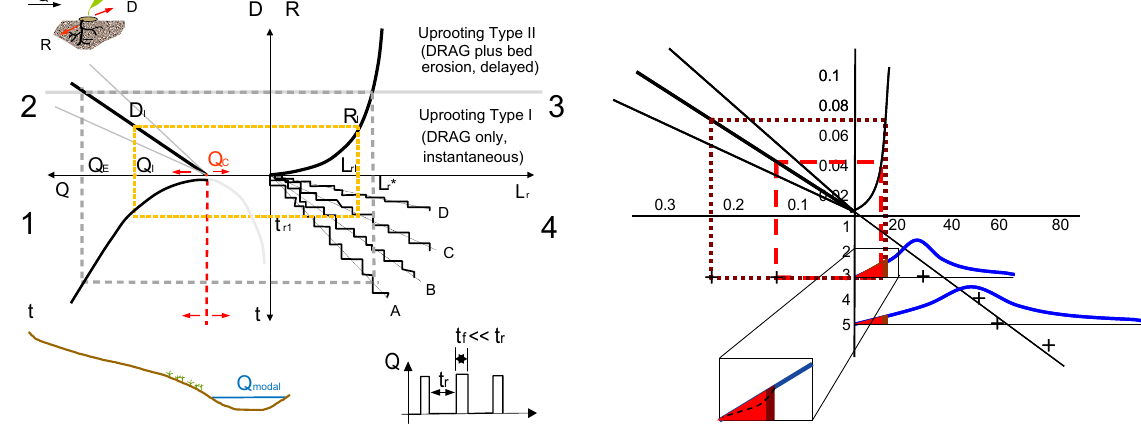
Fig. 3. Left: conceptual model of frictional root erosion relating forces and processes involved in the Type I root erosion mechanism. Q : flow at certain elevation of river section; D : effective flow-induced drag; R : effective resistance to uprooting in wet conditions; L : root factor including root length and architecture. Right: stochastic conceptualization of Type I root erosion mechanism.